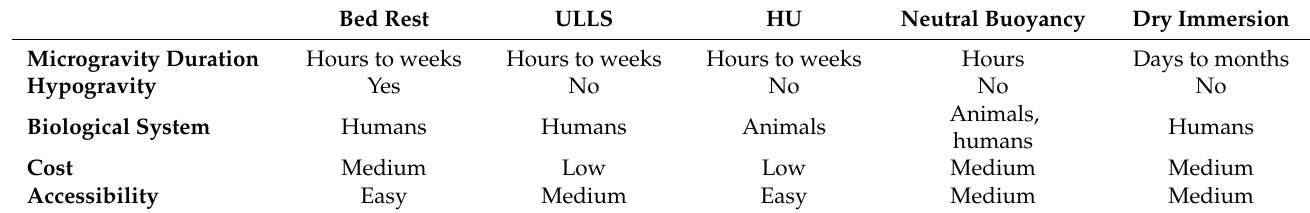
Table 2. Specifications of ground microgravity analogues. ULLS, unilateral lower limb suspension; HU, hindlimb unloading.